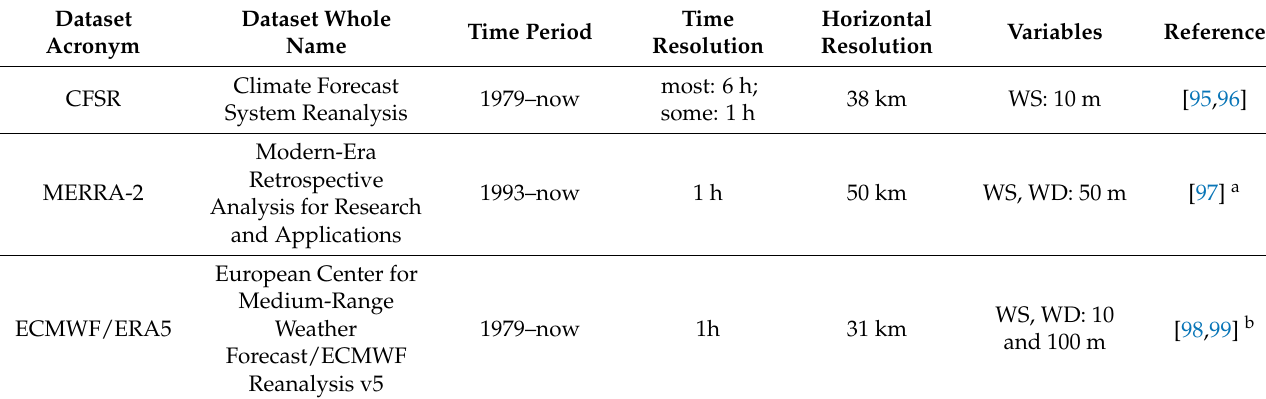
Table 4. Most commonly used datasets main